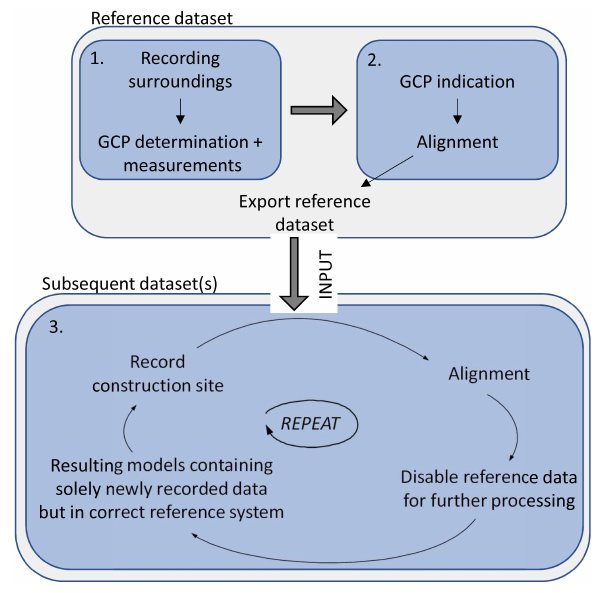
Figure 2: Methodology